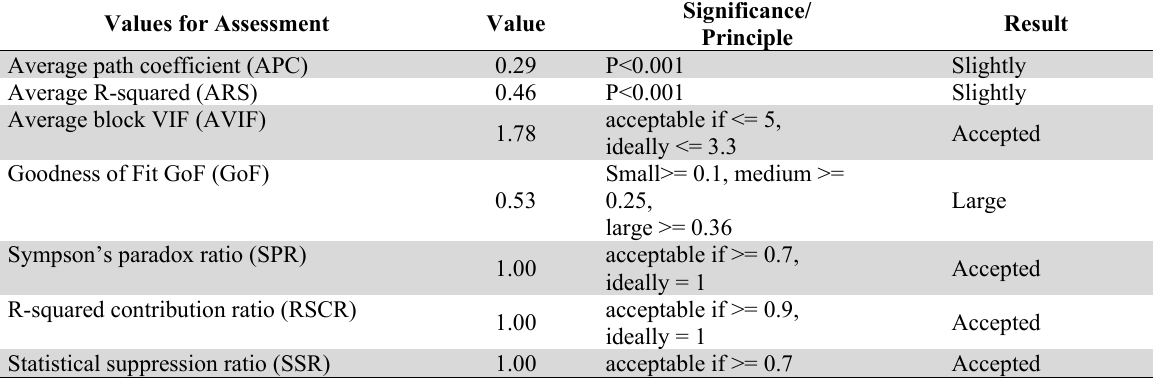
Result of the model assessment